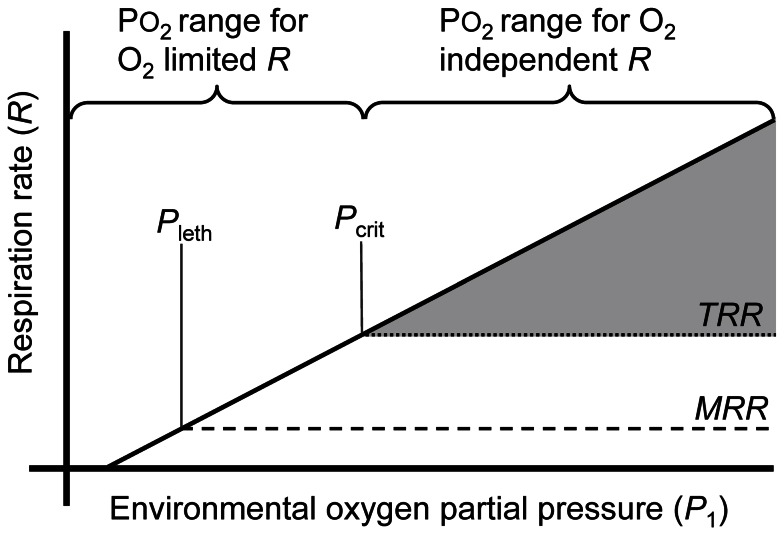
Relationship between an organism’s respiration rate and the environmental oxygen partial pressure.In this conceptual diagram, the solid line represents the linear relationship between environmental oxygen partial pressure and an organism’s theoretical maximum respiration rate, as predicted by Fick’s Law First of Diffusion (Eq. 1). Critical oxygen partial pressure (P
crit) is the environmental oxygen level below which an organism’s theoretical maximum respiration rate is lower than its normal, or target respiration rate (TRR, dotted line). Respiration rate is oxygen limited when environmental oxygen partial pressure is below this critical partial pressure. Above the critical partial pressure respiration rate is generally independent of environmental oxygen (indicated by gray shading). Lethal oxygen partial pressure (P
leth) is the environmental oxygen level below which an organism’s theoretical maximum respiration rate is lower than its minimum survivable (non-lethal) respiration rate (MRR, dashed line). Hypoxia-induced mortality will increase when environmental oxygen partial pressure is below this lethal oxygen partial pressure.